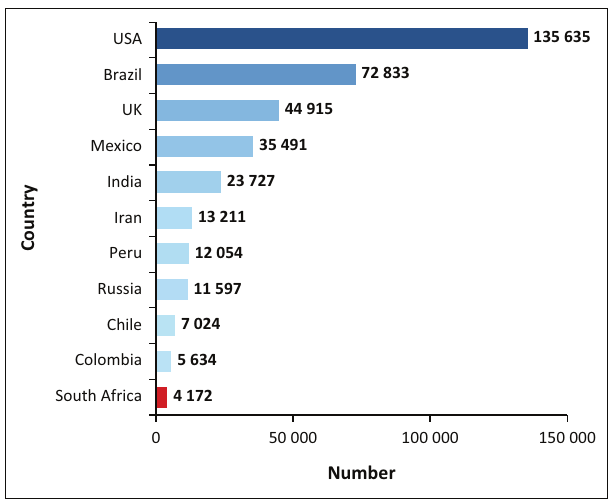
FIGURE 1-A1: The number of COVID-19 deaths in different countries as of 13 July